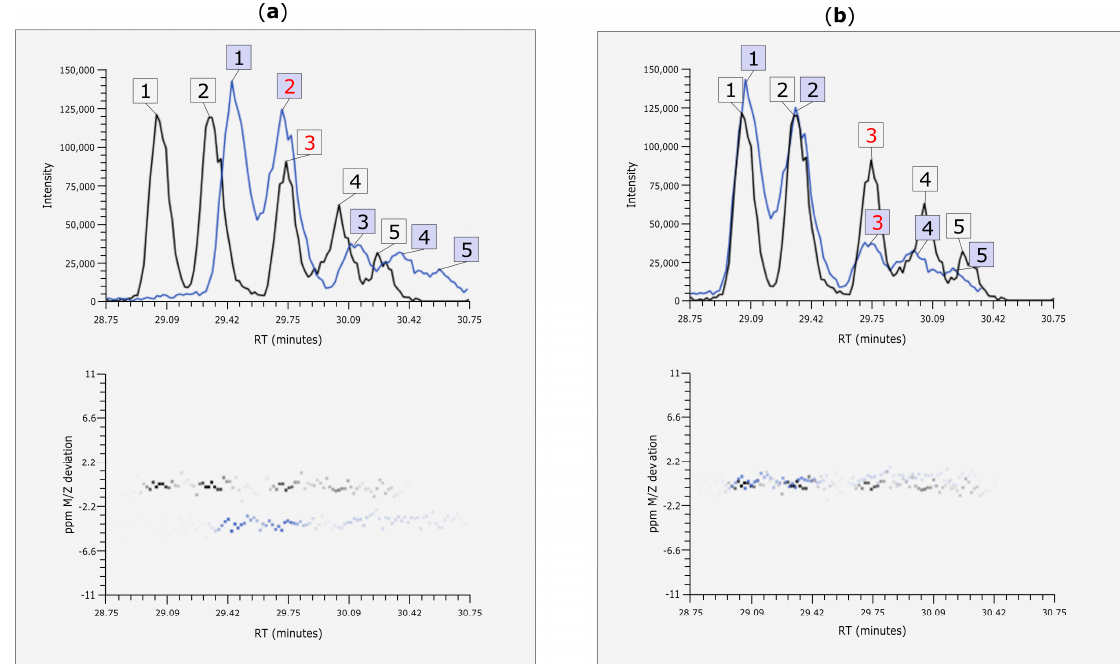
Figure 7. EIC (alignment before and after retention time (Rt) alignment and mass-to-charge ratio ( m / z )) correction with MetMatch. ( a ) A phenylalanine-derived chromatographic peak was annotated at position 3 in the reference file (black) and thus included in the reference feature list. The target peak (blue) at position 2 would probably be matched to it by means of manual matching or any other alignment approach that does not account for Rt shift; ( b ) Extracted ion chromatograms (EICs) after Rt and m / z shift correction using MetMatch. When the two corrected EICs are viewed simultaneously, it is apparent that each target peak should be matched to the reference peak denoted by the same ID number and that a systematic m / z shift is present between the two chromatograms.